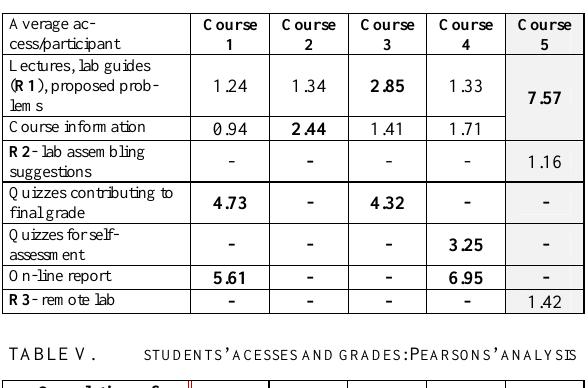
S UMMARY : AVERAGE ACCESSES PER ACTIVE PARTICIPANT